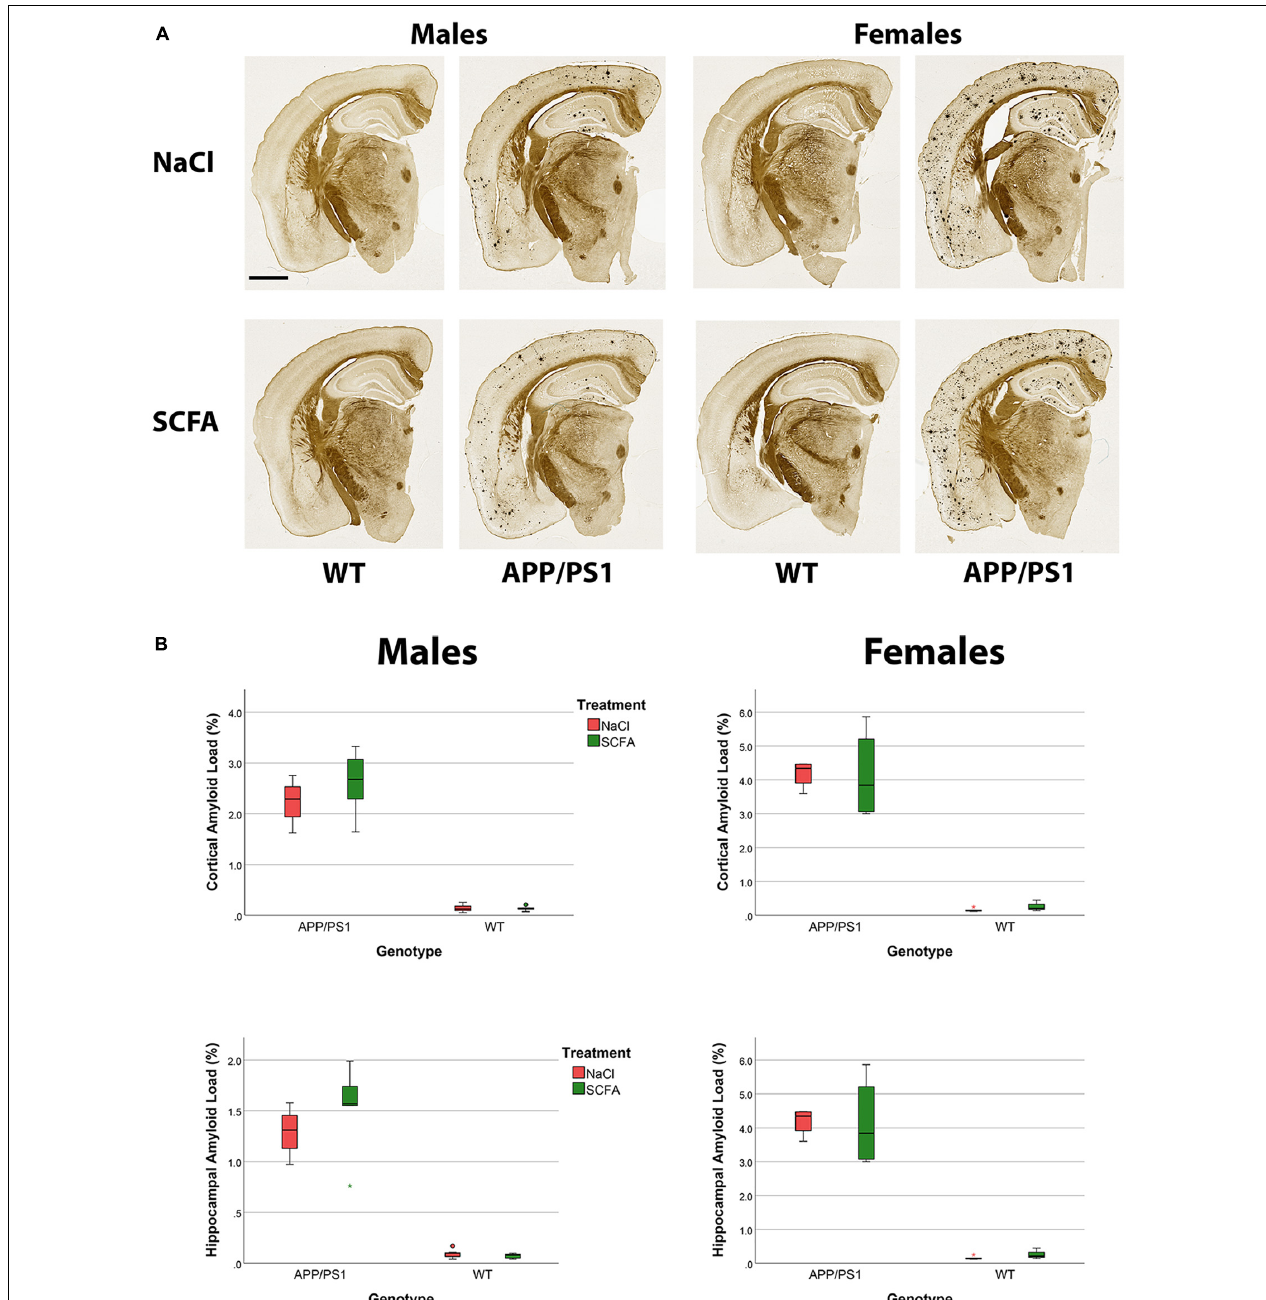
FIGURE 8 | Amyloid staining and quantification indicate no significant short chain fatty acids (SCFA) effect although an increased amyloid load is observed in female mice. The Campbell–Switzer silver stain labels both parenchymal amyloid and cerebral vascular amyloid (A) . Scale bar represents 1 mm. Statistical analysis confirms a significant difference with sex and genotype but not SCFA treatment (B) . Staining was quantified using HALO Area Quantification v.2.2.1. Statistical significance was determined by using a general linear model. Datapoints marked as circles represent ourliers ( 3rd quartile + / − 1.5 × interquartile range) while asterisks mark extreme outliers (3rd quartile + / − 3 × interquartile